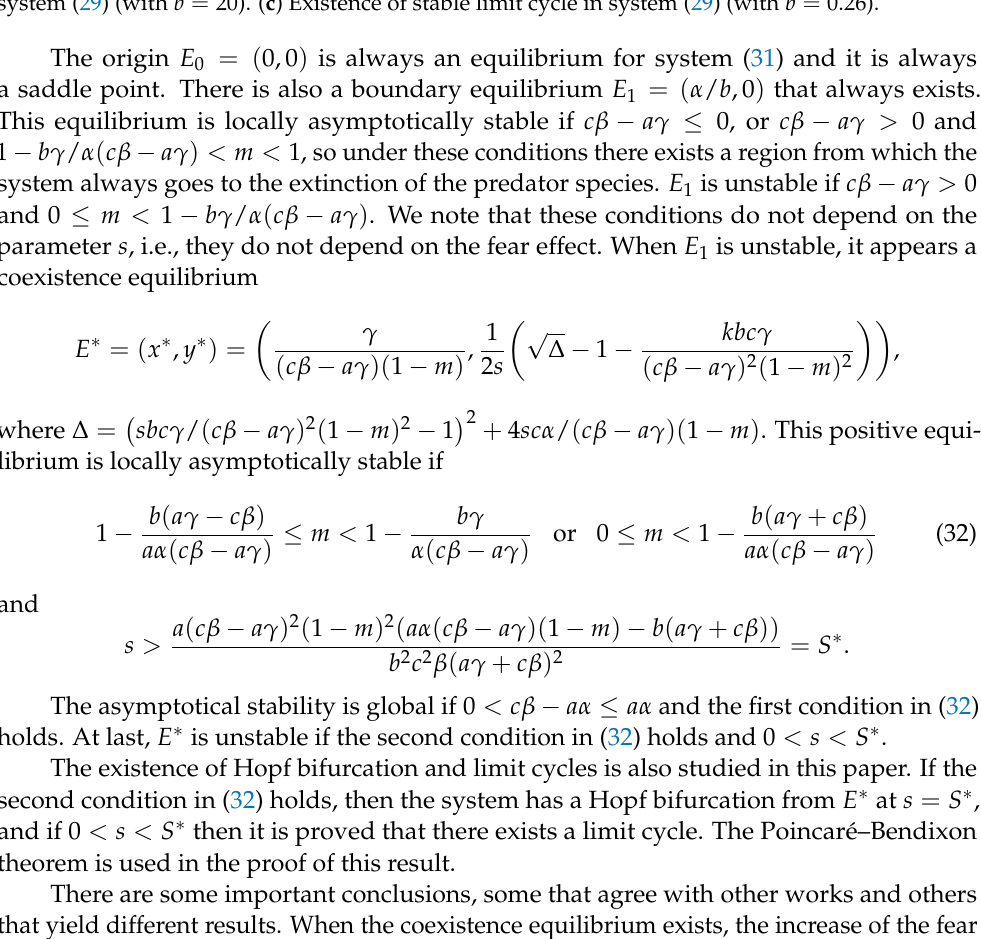
Figure 8. Dynamic behaviors with r = 1, m = 0.25, s = 1.5, a = 1, K = 1, α = 0.5 and n = 0.12. ( a ) Extinction of both species in system (27) (with m = 2). ( b ) Coexistence of both species in system (29) (with b = 20). ( c ) Existence of stable limit cycle in system (29) (with b =